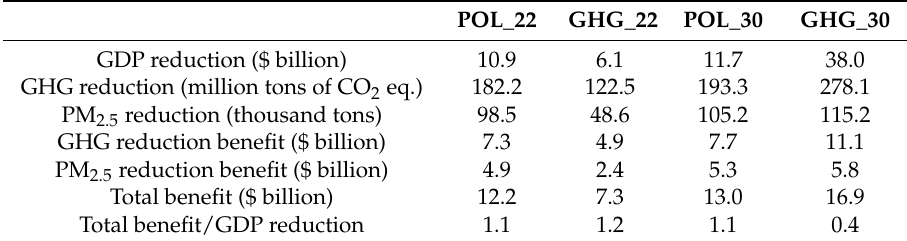
Table 13. GDP reduction and environmental benefits by